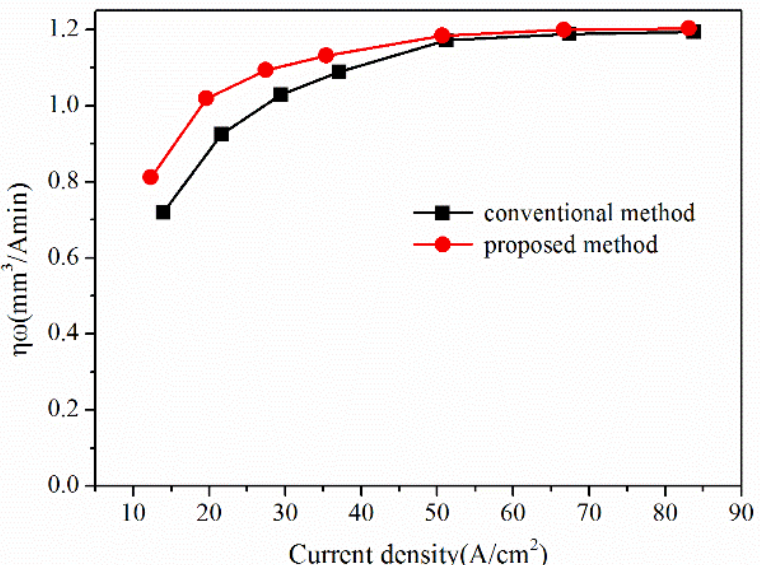
Figure 12. The current efficiency curves of 304SS were obtained by conventional and proposed method simulations.